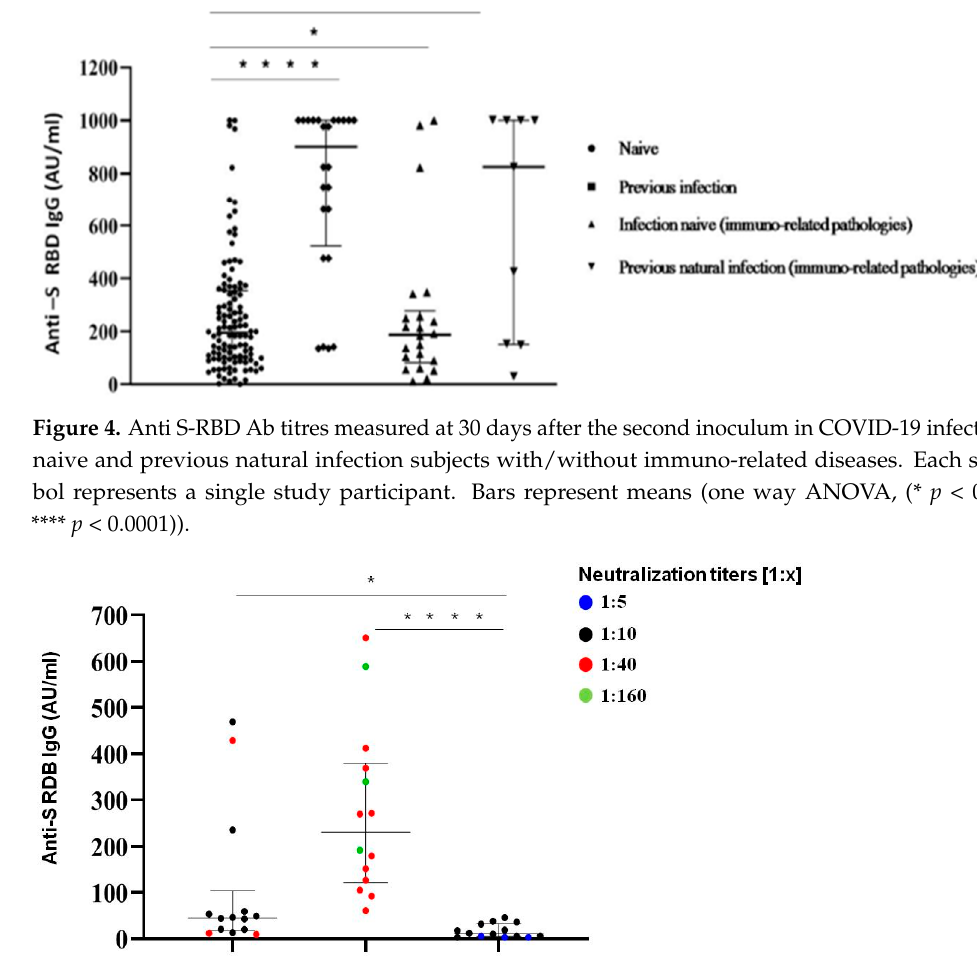
Figure 5. Immunological responses over 270 days after two doses of BNT162b2 mRNA vaccine. Comparative anti S-RBD Abs and neutralization titres measured at T1 (time of second dose), T2 (30 days after second dose) and T3 (>270 days after the second inoculum) in COVID-19 infection-naive subjects. Distribution of variables was evaluated by Shapiro–Wilk test. Non-parametric variables were expressed as median (IR, interquartile range). We compared IgG Ab levels with in vitro virus neutralization using one-way ANOVA Kruskal–Wallis tests (* p < 0.05; **** p <